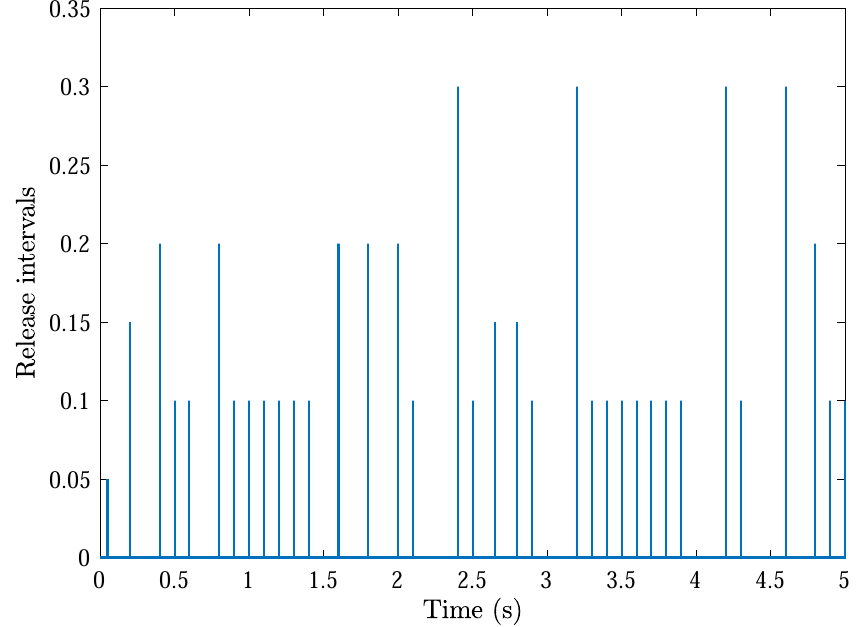
Figure 7. Event-triggered communication instants and release intervals of UAV